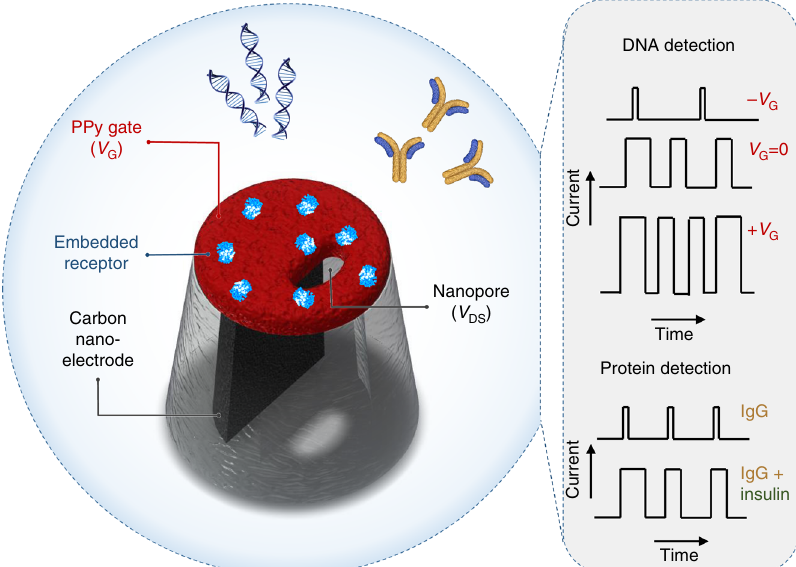
Fig. 1 Schematic of the nexFET biosensor. The nexFET platform is a functionalizable ionic nanopore transistor and is based on a dual-barrel quartz nanopipette with one barrel fi lled with a carbon nanoelectrode that also forms in a localized manner around the pipette tip. The ring-like carbon-electrode surrounding the nanopore is coated with PPy using ionic current feedback controlled electropolymerization, which serves to decrease the opening size of the second barrel. The PPy acts as a gate electrode surrounding the second barrel, a nanopore, that remains open and acts as a drain-source channel. By controlling the gate voltage molecular transport properties and event rates can be ef fi ciently controlled at the single-molecule level. In addition, the PPy gate layer is ideally suited for embedding of arti fi cial receptors that can be used for selective molecular sensing. Both strategies are explored for DNA detection and for protein